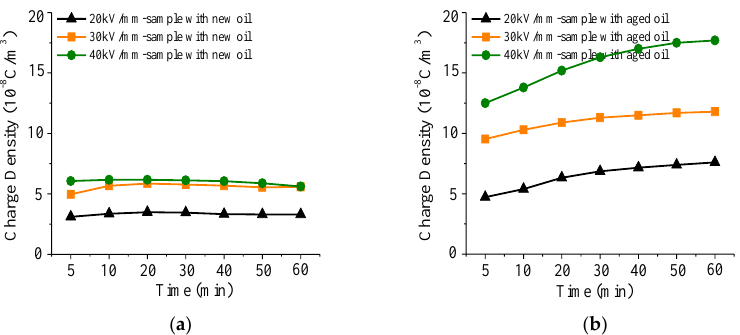
Figure 3. Trapped charges amount in the sample with new and aged oil under volt-off condition. ( a ) charges amount in sample with new oil; ( b ) charges amount in sample with aged oil.